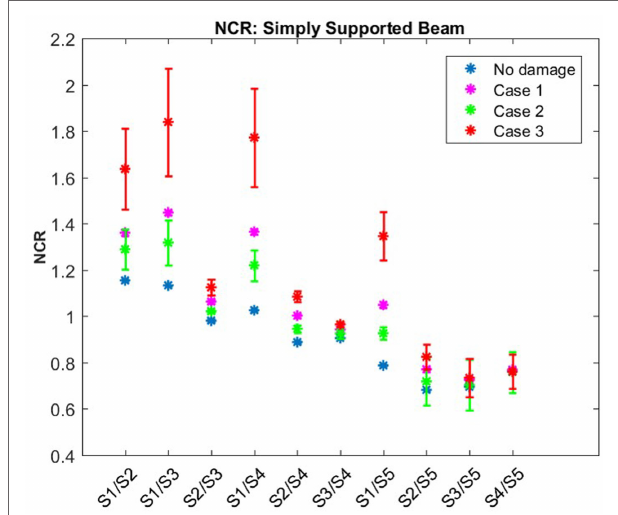
FIGURE 9 | NCRs of aluminum beam in laboratory testing.